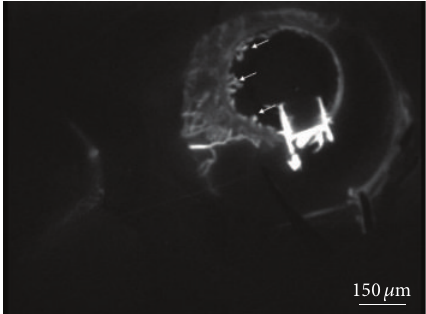
Figure 5: Retrograde filling furthest in Schlemm’s canal was observed in the quadrants where the pathway was functioning